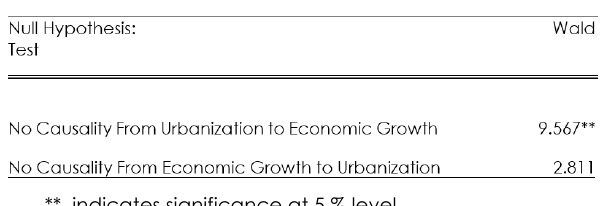
Table 5. Granger Causality Test (TY based)